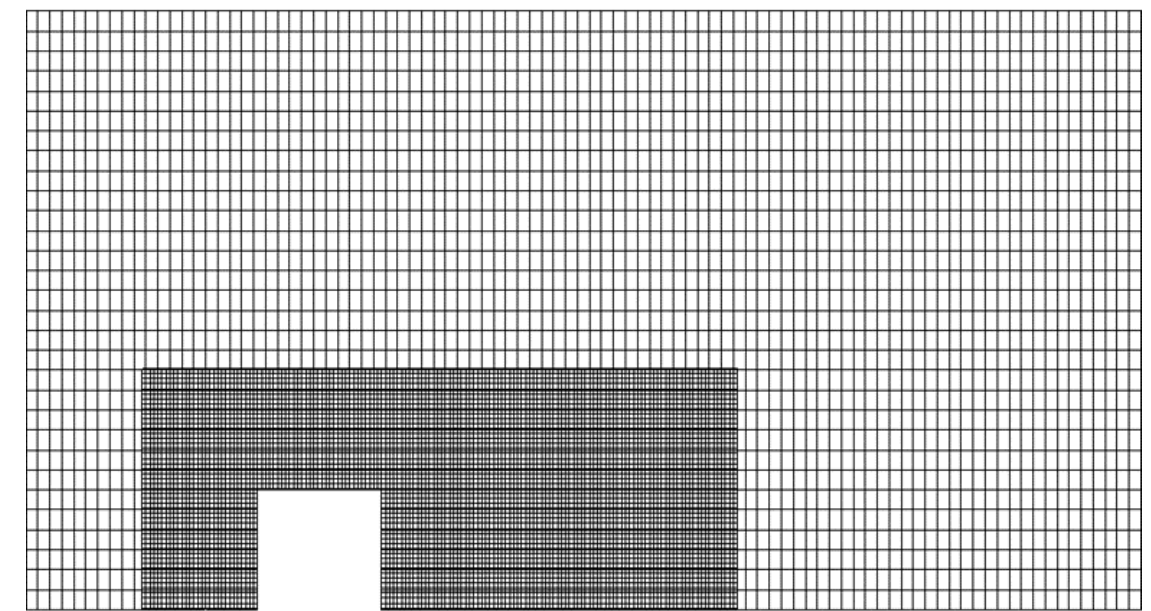
Figure 5. Root and nested computational domains of the flow field.